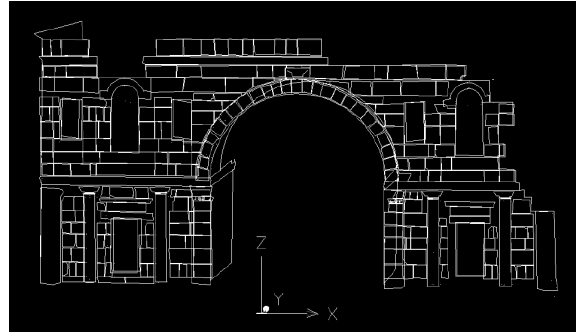
Figure 12 – Bosra, the Nabatean Arch